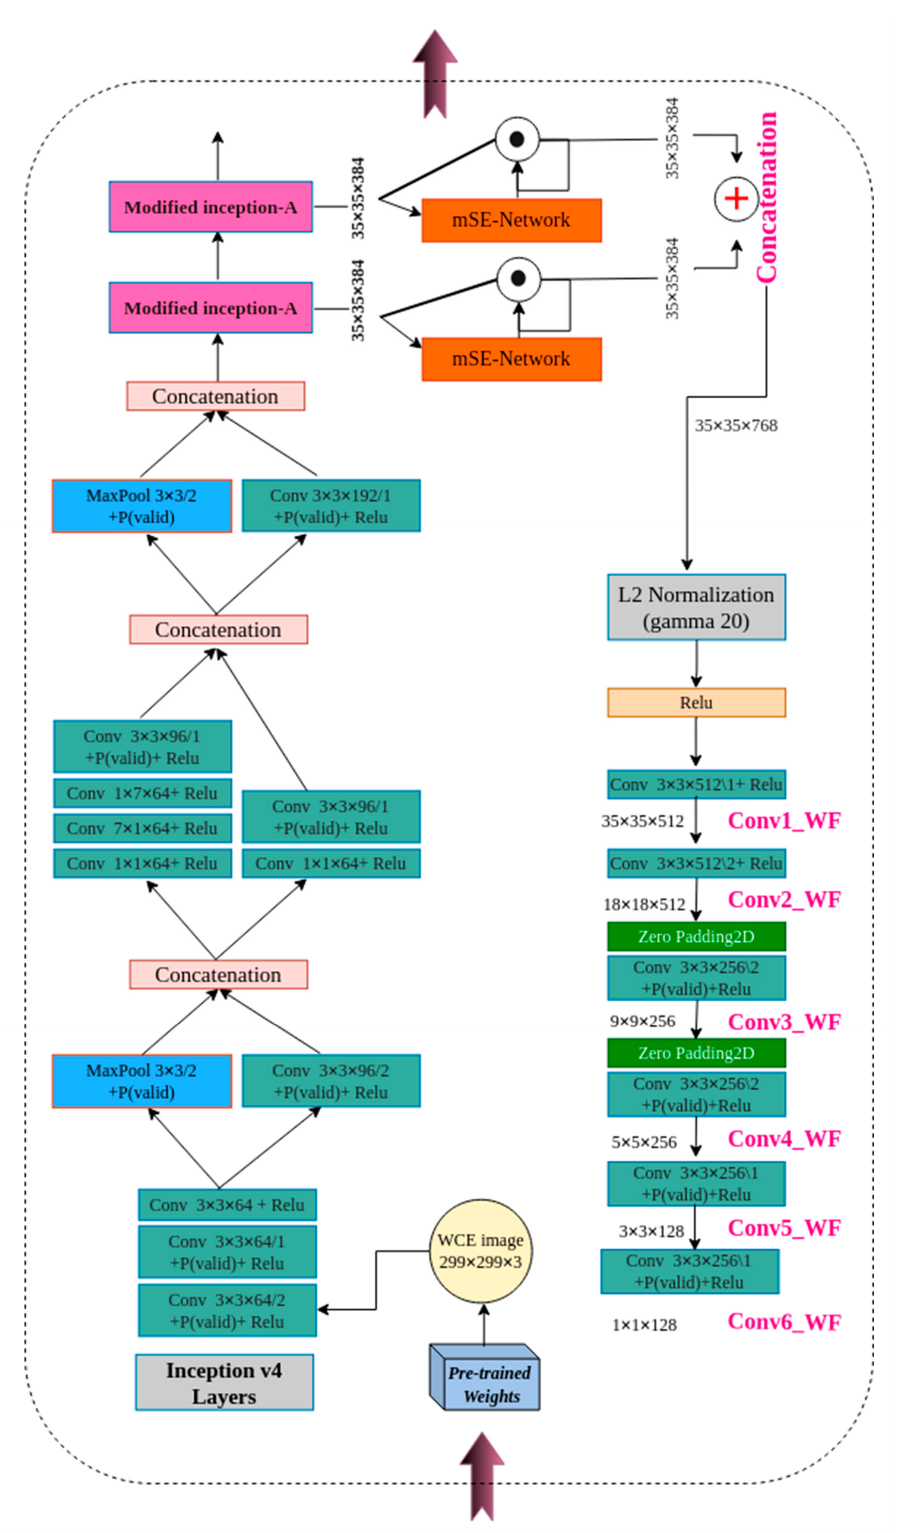
Figure 6. Detailed structure of the Hyb-SSDNet